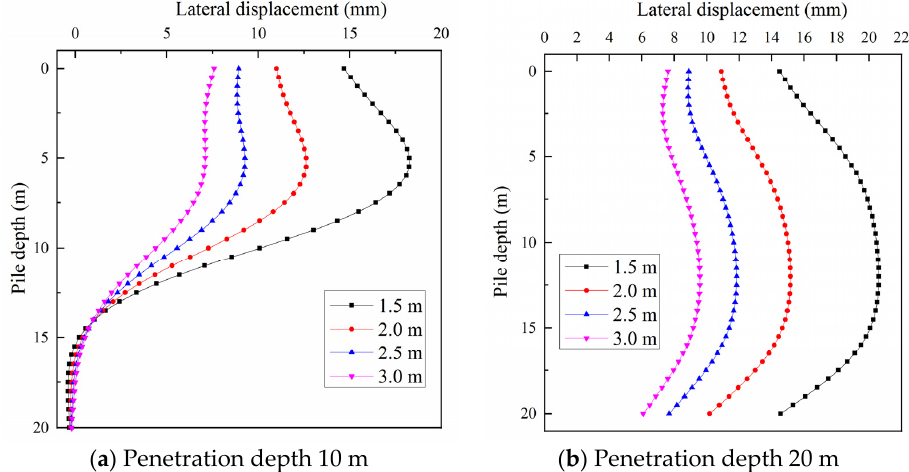
Figure 14. Influence of the distance between the used and new piles on lateral displacement of used pile.